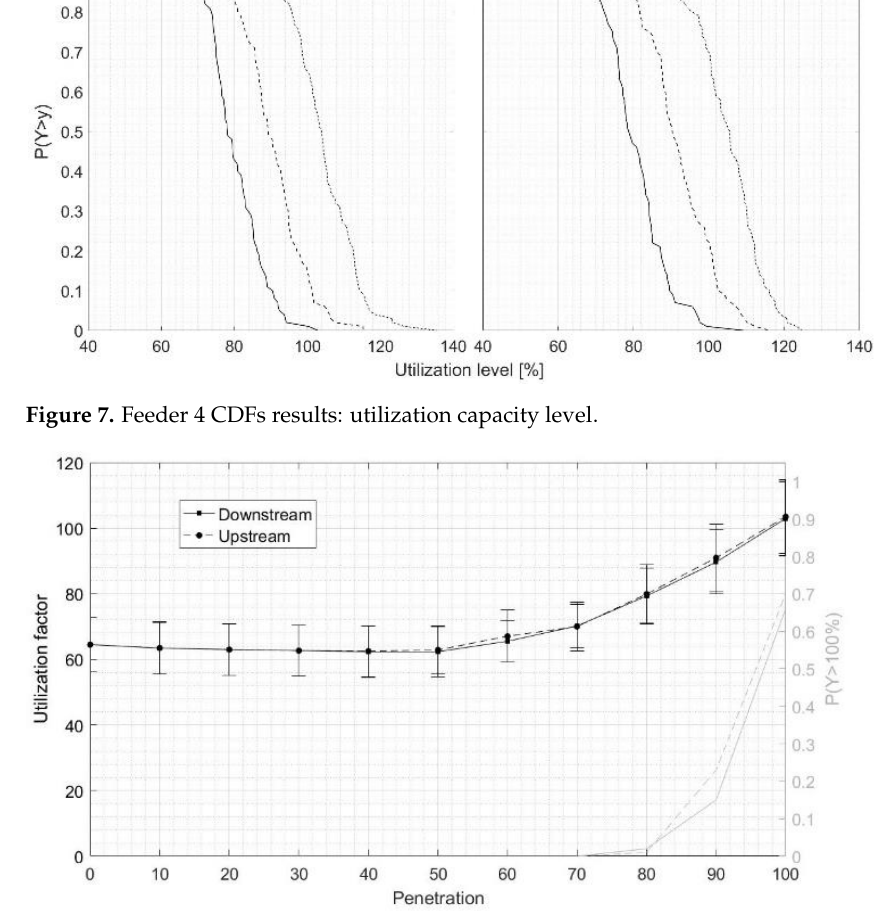
Figure 8. Feeder 4: the probability of utilization factors higher than 1.0 (>100%).